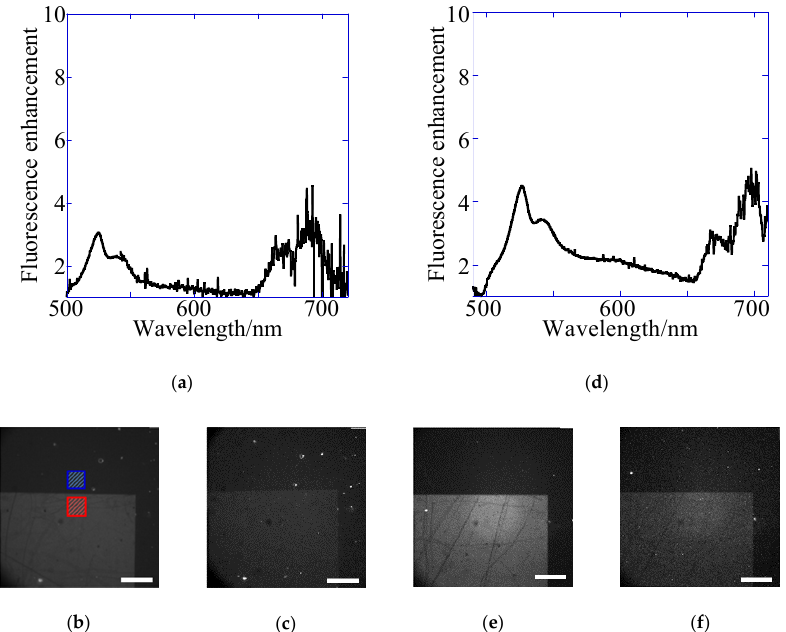
Figure 6. ( a , d ) fluorescence spectra and images of YG detected with ( b , e ) emGFP (495–540 nm), ( c , f ) emCy3 (570–615 nm) filters for the 2D plasmonic chip on epi-fluorescence ( a – c ) and transmitted-light systems ( d – f ). The fluorescence enhancement was evaluated by the ratio of the fluorescence intensity in ROI for the grating area (red square) to that for flat metal area (blue square) in fluorescence images as shown in ( b ). Table 6. Enhancement effect of YG with exCFP for the 2D chip in the epi-optical system. Emission Filter (Wavelength Range) Total enhancement factor, excitation enhancement and emission enhancement factors (plasmon mode assigned)